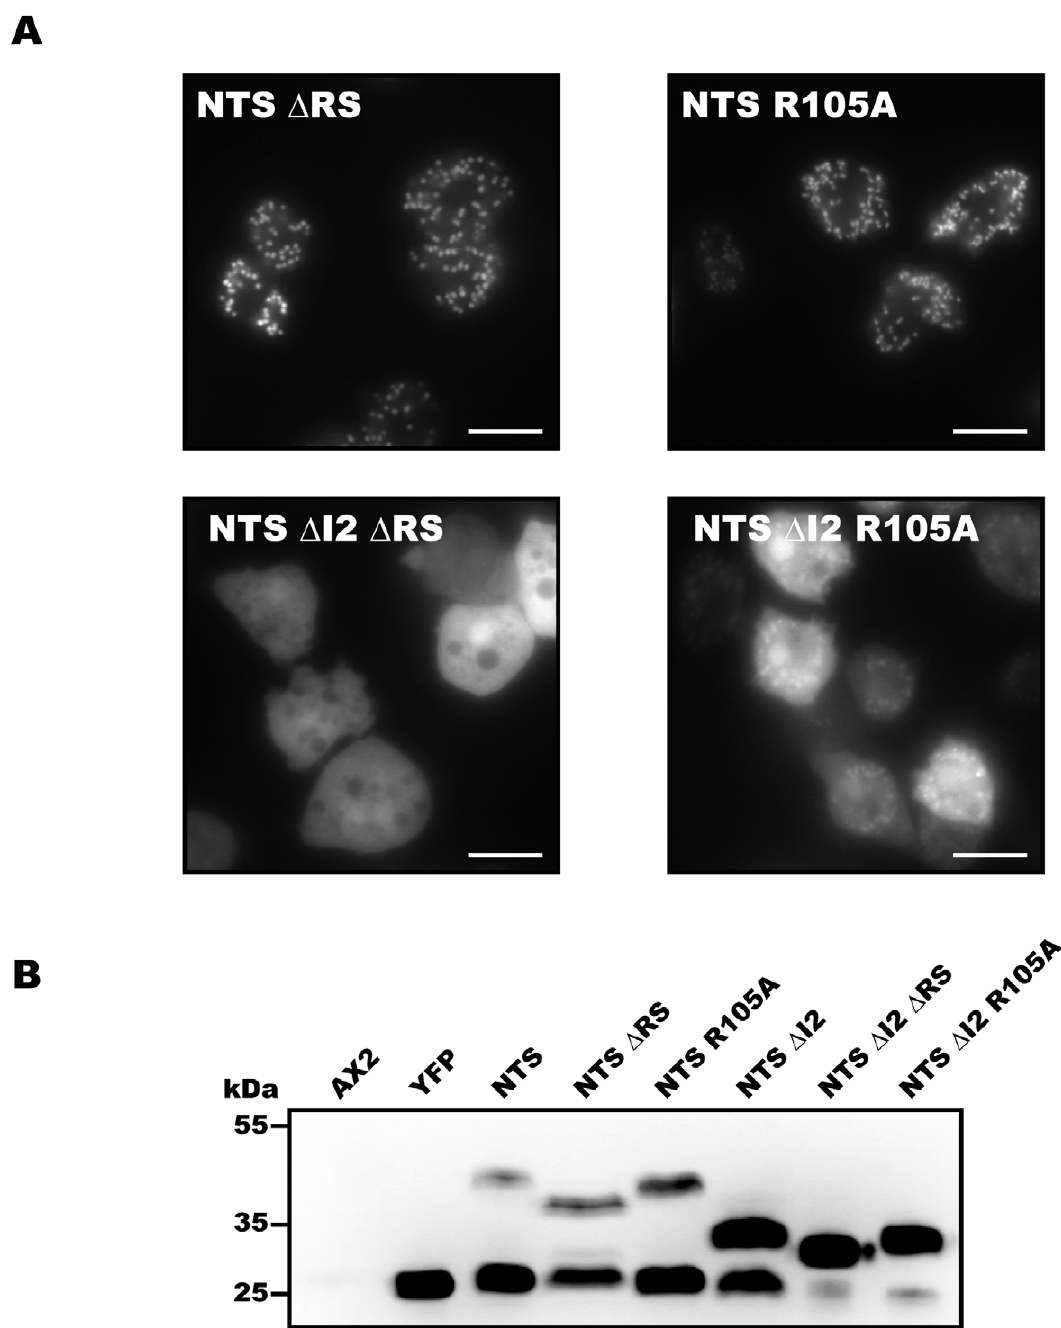
Figure 5. Importance of the R-like recognition sequence for mitochondrial targeting and processing. ( A ) Live cell epiflorescence imaging indicates that NTS– D RS and NTS–R105A are targeted to mitochondria, while NTS D I2– D RS and NTS D I2–R105A show less efficient mitochondrial targeting in D. discoideum . Scale bars, 10 m m. ( B ) Immuno-blot loaded with whole cell lysate from untransformed D. discoideum cells (AX2), cells producing EYFP, and EYFP-tagged constructs NTS, NTS– D RS, NTS–R105A, NTS D I2, NTS D I2– D RS, and NTS D I2–R105A. Similar to NTS, NTS– D RS and NTS–R105A undergo processing. Processing is greatly impaired in the case of NTS D I2– D RS and NTS D I2–R105A.